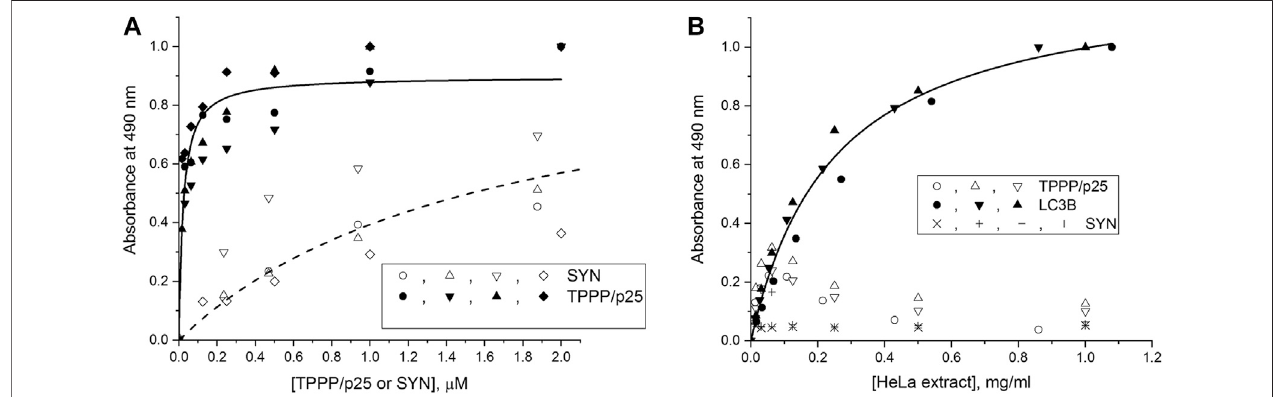
FIGURE1| InteractionoftheautophagymarkersLC3BandSQSTM1/p62withSYNorTPPP/p25asdetectedbyELISA. (A) BindingofhumanrecombinantTPPP/ p25 ( C , ▲ , ▼ , ◆ ) and SYN ( ○ , Δ , ∇ , ◊ ) to LC3B. TPPP/p25 or SYN at different concentrations were added to LC3B immobilized on the plate, and the binding af fi nities evaluated by curve fi tting, assuming simple hyperbolic saturation, are as follows: K d (cid:2) 21.5 ± 4.1 nM (TPPP/p25, n (cid:2) 4) and 1.62 ± 0.32 μ M (SYN, n (cid:2) 4). (B) Binding of endogenous SQSTM1/p62 from HeLa cell extract to the immobilized LC3B ( C , ▲ , ▼ ), TPPP/p25 ( ○ , Δ , ∇ ) or SYN (x, +, ǀ , — ). The plate was coated with LC3B, TPPP/p25 or SYN, and the immobilized proteins were incubated with HeLa cell extract expressing endogenous SQSTM1/p62 at various concentrations. EC 50 value evaluated by curve fi tting, assuming simple hyperbolic saturation, is: EC 50 (cid:2) 0.246 ± 0.024 mg/ml for LC3B. n (cid:2) 3 for TPPP/p25 and LC3B, n (cid:2) 4 for